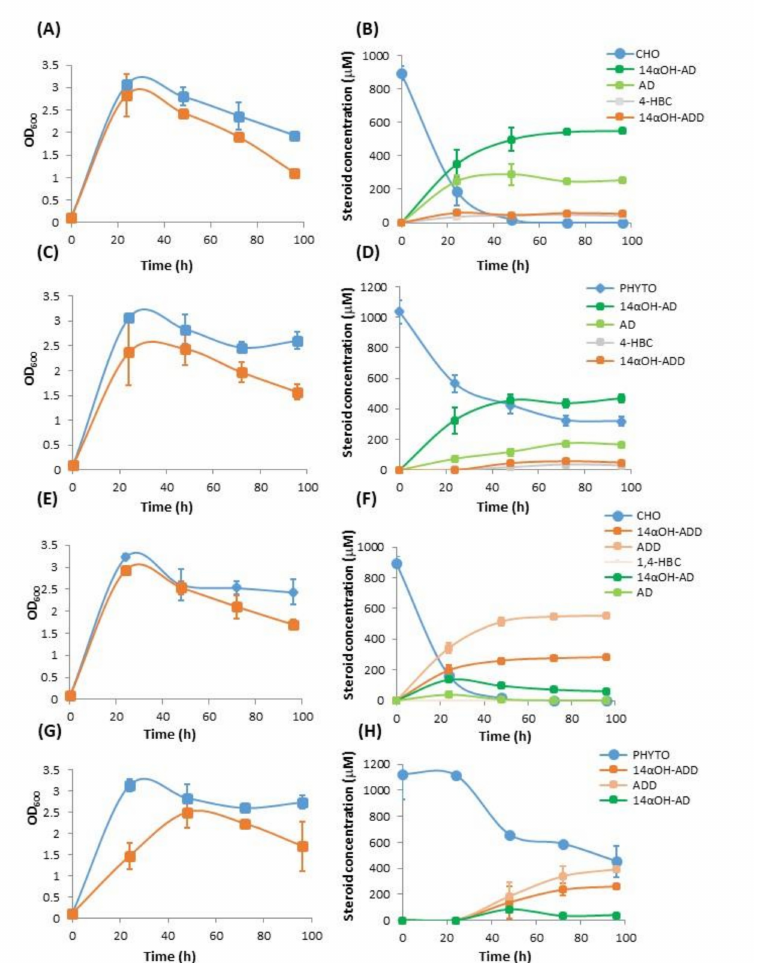
Figure 3. Biotransformation assays in the presence of sterols (CHO or PHYTO) performed with the MS6039-5941 (pMVFAN) and MS6039 (pMVFAN) recombinant strains. Results represent means of three biological replicates. Error bars represent the standard deviation. ( A ) Growth curves of MS6039-5941 (pMVFAN) (red) and MS6039-5941 (pMV261) (blue) strains in the biotransformation medium in the presence of CHO. ( B ) Consumption of CHO and steroidal biotransformation products delivered by MS6039-5941 (pMVFAN). ( C ) Growth curves of MS6039-5941 (pMVFAN) (red) and MS6039-5941 (pMV261) (blue) strains in the biotransformation medium in the presence of PHYTO. ( D ) Consumption of PHYTO and steroidal biotransformation products delivered by MS6039-5941 (pMVFAN). ( E ) Growth curves of MS6039 (pMVFAN) (red) and MS6039 (pMV261) (blue) strains in the biotransformation medium containing CHO. ( F ) Consumption of CHO and steroidal biotransfor- mation products delivered by MS6039 (pMVFAN). ( G ) Growth curves of MS6039 (pMVFAN) (red) and MS6039 (pMV261) (blue) in the biotransformation medium containing PHYTO. ( H ) Consumption of PHYTO and steroidal biotransformation products delivered by MS6039